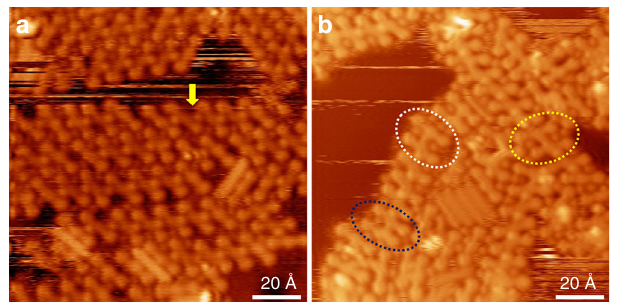
Fig. 6 Covalent connection upon annealing of the organometallic chains from 6 . a STM image of organometallic chains from 6 at 315 K. One Ag adatom in alkynyl – Ag – alkynyl is pointed by the yellow arrow. b STM image recorded after annealing the sample in a to 420 K. The H-type product is marked by dark blue circle; Glaser product at the termini of chain is marked by white circle; Glaser product in the middle of chain is marked by yellow circle Tunneling parameters: a V = − 1.6 V, I = − 0.2nA; b V = − 1.3V, I =